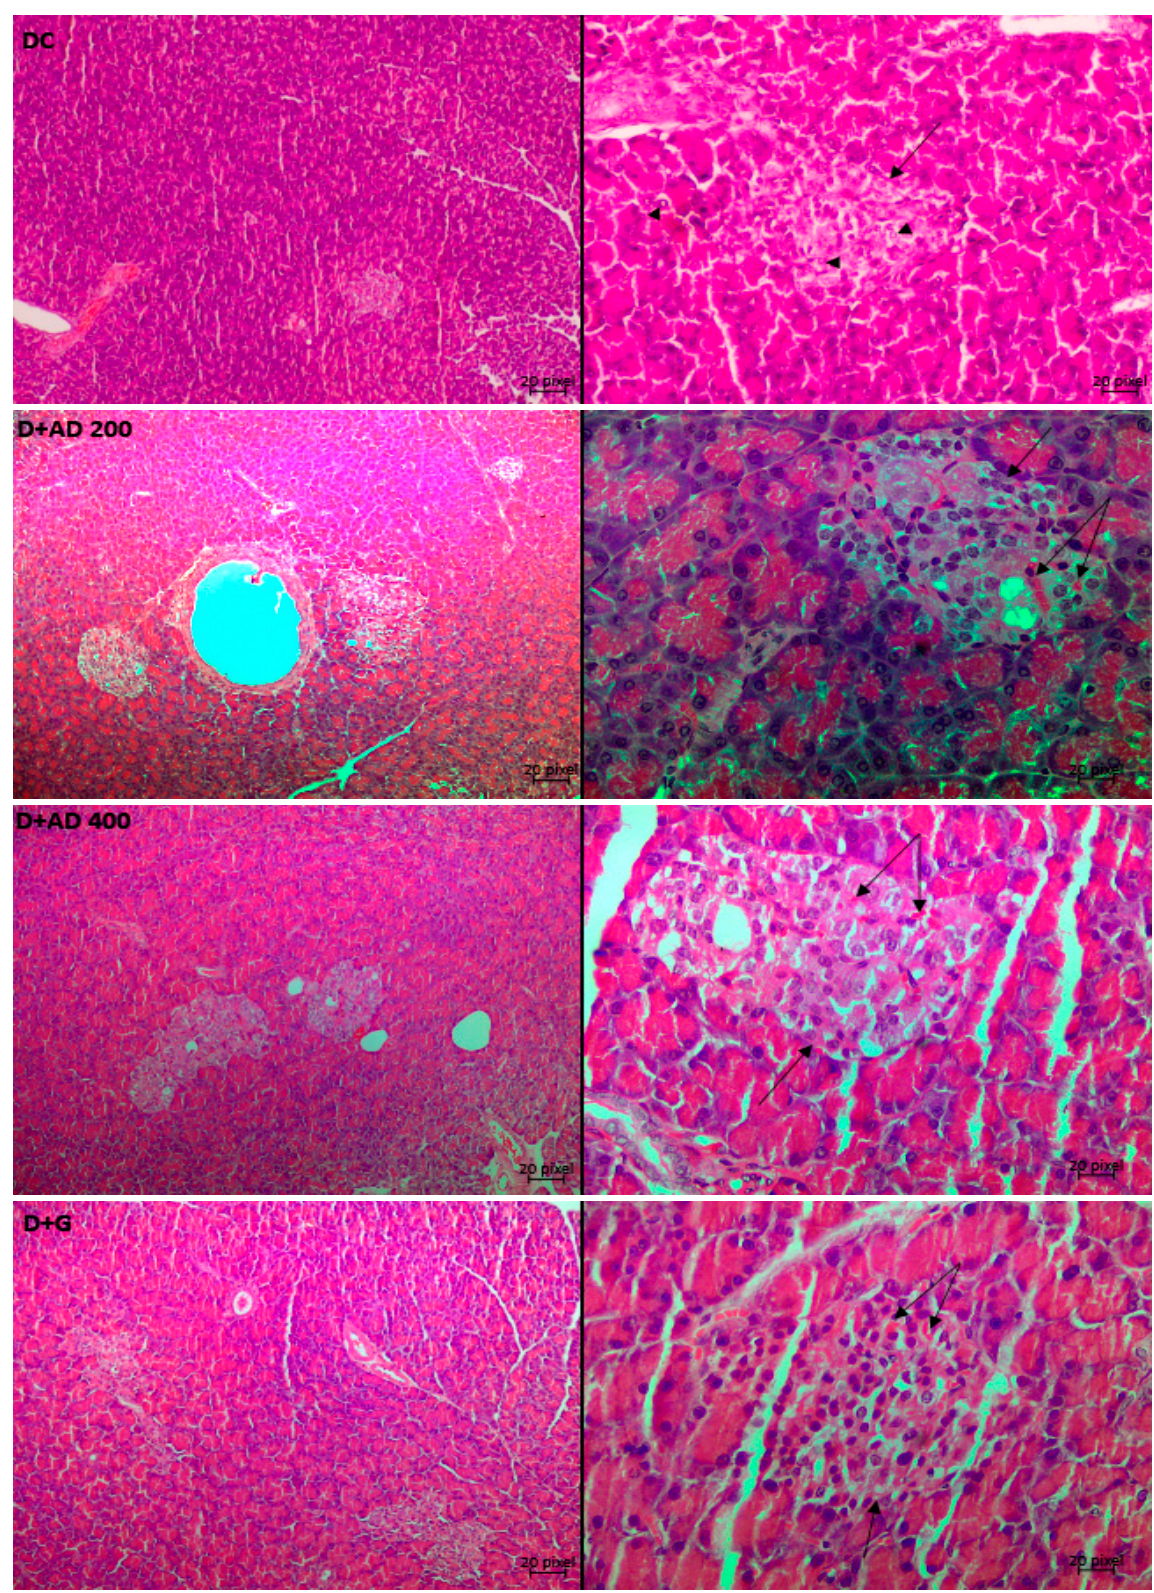
Figure 9. Light photomicrographs of haematoxylin and eosin-stained pancreatic tissue of normal and diabetic rats. Single arrows point to the basement membrane of the islets, while double thin arrows are showing the islet capillaries. Arrow heads show vacuolated nuclei in the acinar and islet cells. Magnification 10 × ( left ) and 40 × ( right